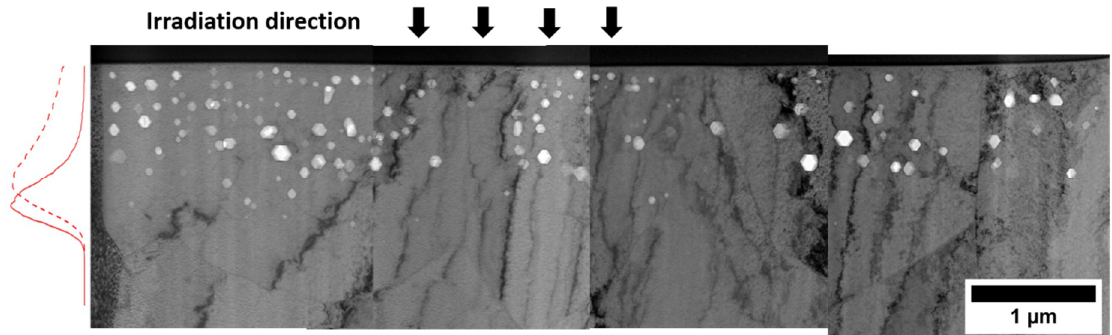
Figure 2. TEM micrograph of irradiated Fe at a region far away from trenches. Normalized dpa and implanted interstitial profiles are shown on the left side.